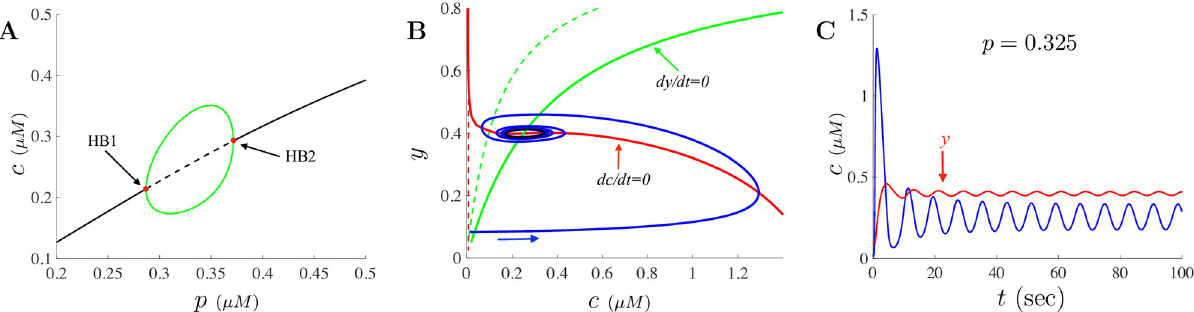
Fig 1. Dynamics and bifurcation structure for constant IP 3 . A shows the bifurcation structure for Eqs (6) and (7) for constant values of p . A classic Hopf bubble emerges between two Hopf bifurcation points labeled HB1 and HB2. The black solid line corresponds to stable fixed points while the dashed black curve are unstable fixed points. B shows the nullclines when p = 0 (dashed curves) and when p = 0.325 (solid curves). The nullclines corresponding to dc / dt = 0 and dy / dt = 0 are given by the red and green curves, respectively. A trace of the solution when p = 0.325 is given by the blue trajectory and is attracted to a period orbit (dark blue). The oscillating solution to the model when p = 0.325 is shown in C as a function of time with the corresponding solution to the y equation is shown in red.